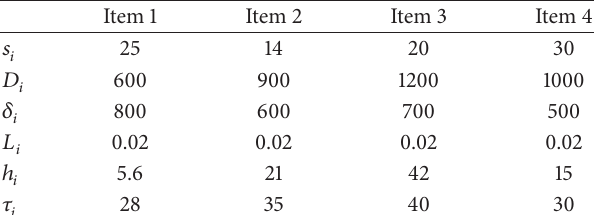
Table 1: The basic data under deterministic situation.